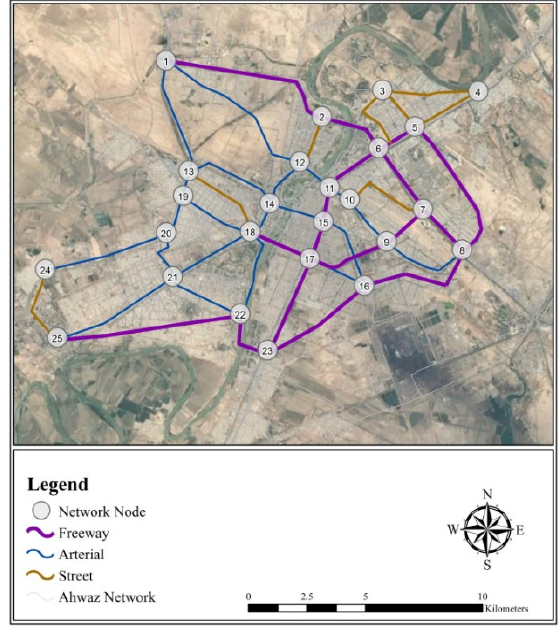
Figure 6. Ahvaz network (links and nodes) Figure 7. Proposed BRT lines and positions of deteriorated land use areas and TOD